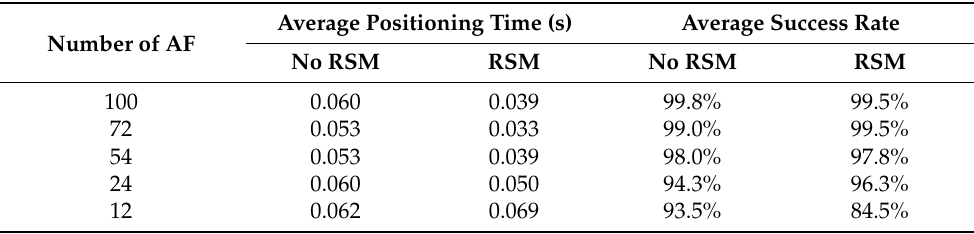
Table 15. Total average positioning time and success rate of methods using or not using